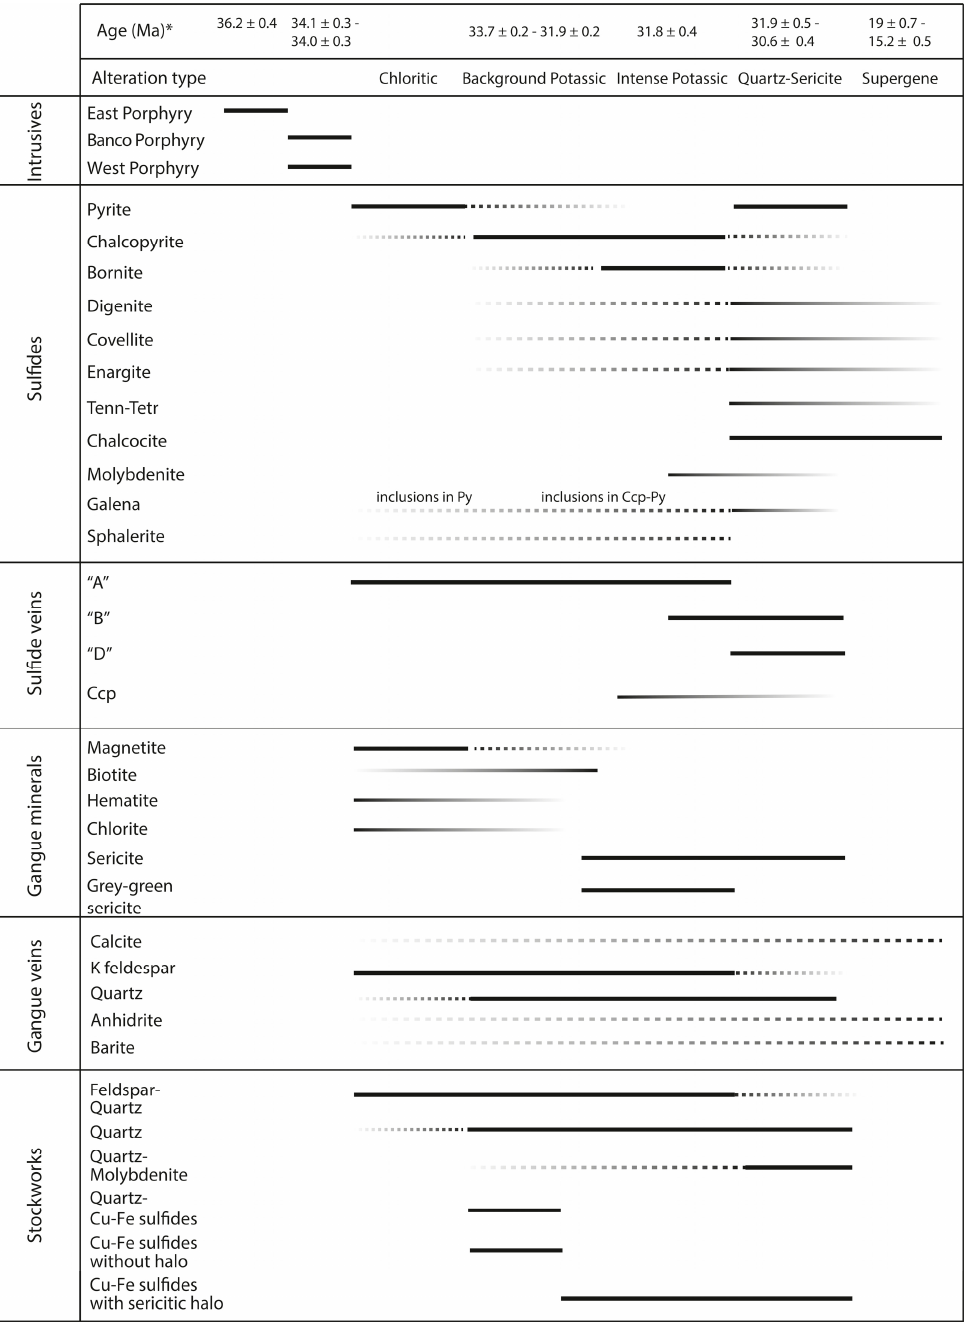
Figure 5. Paragenetic sequence for the Chuquicamata Underground deposit. * Data sources: Sillitoe and McKee, 1996 [54], Reynolds et al., 1998 [50], Mathur et al. [53], Ballard et al., 2001 [44], Rivera et al., 2012 [45], and Barra et al., 2013